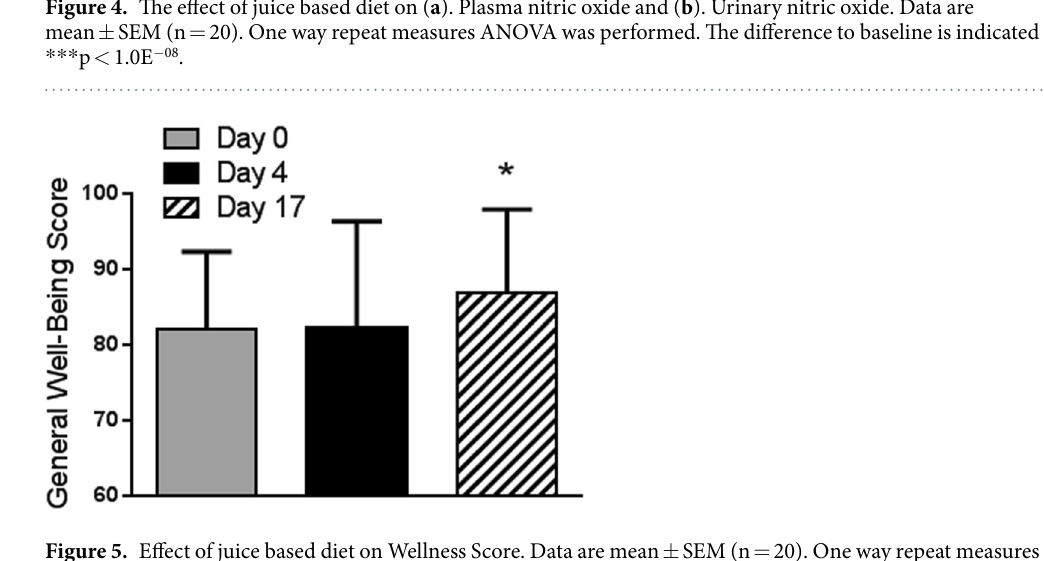
Figure 5. Effect of juice based diet on Wellness Score. Data are mean ± SEM (n = 20). One way repeat measures ANOVA was performed. The difference to baseline is indicated * p <